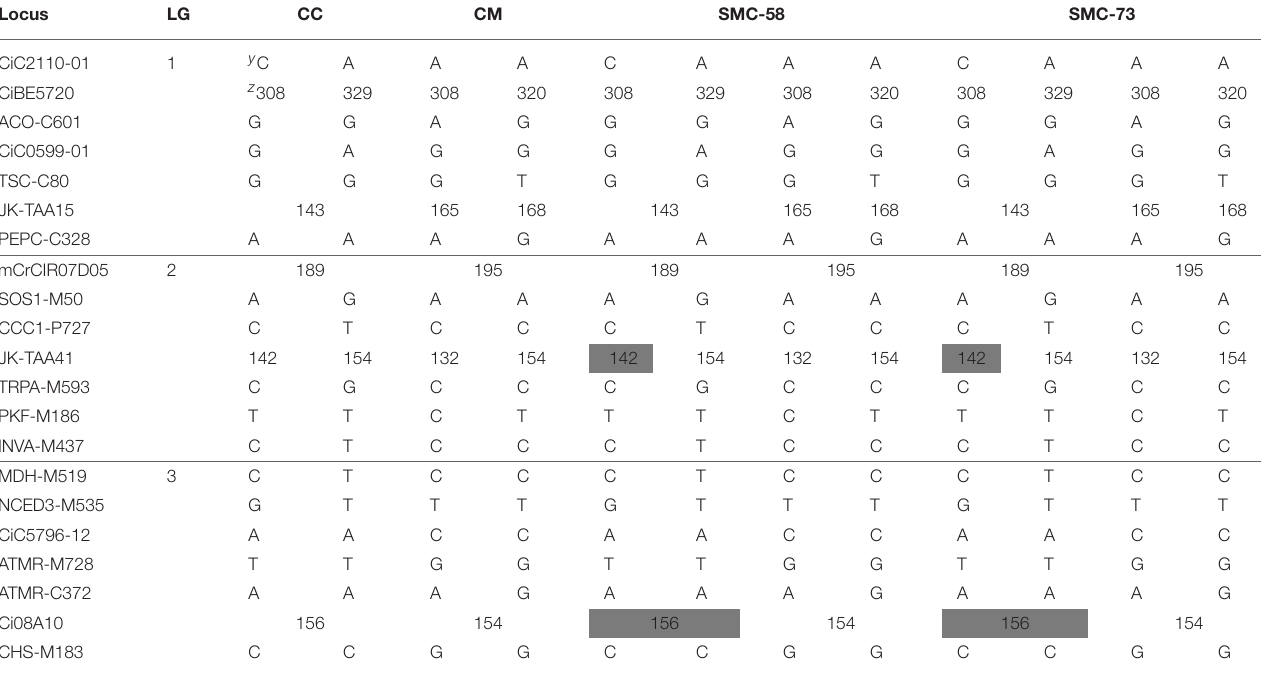
TABLE 5 | Genetic analysis using SNP and SSR nuclear markers located on LGs 1, 2, and 3 performed on SMC-58 and SMC-73 somatic hybrids that were obtained by protoplast fusion between C. macrophylla (CM) and Carrizo citrange (CC). Locus LG CC CM SMC-58 CiC2110-01